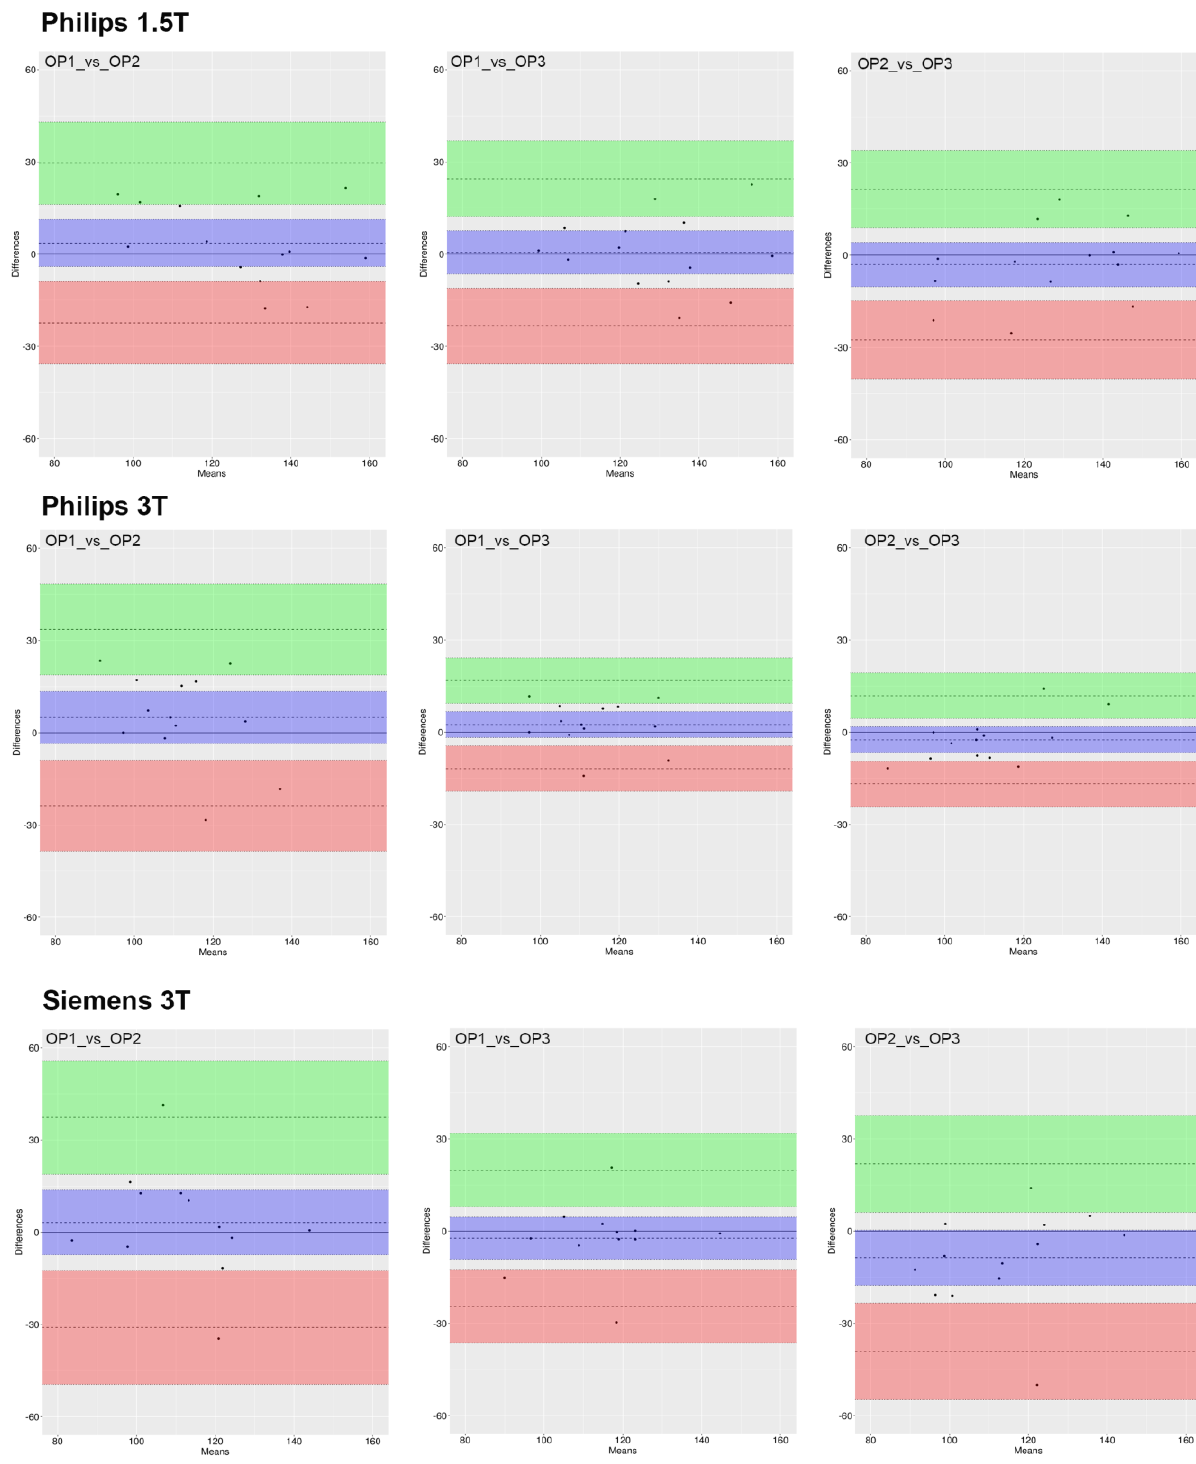
Figure 6. Bland–Altman plot of flow measures for each pair of raters. The dashed line represents the mean difference along with the 95% CI (violet box). The lower (red box) and higher (green box) limits of agreement (LoA) defined as the mean difference ± 1.96 standard deviations of differences are reported along with the corresponding 95% CI.